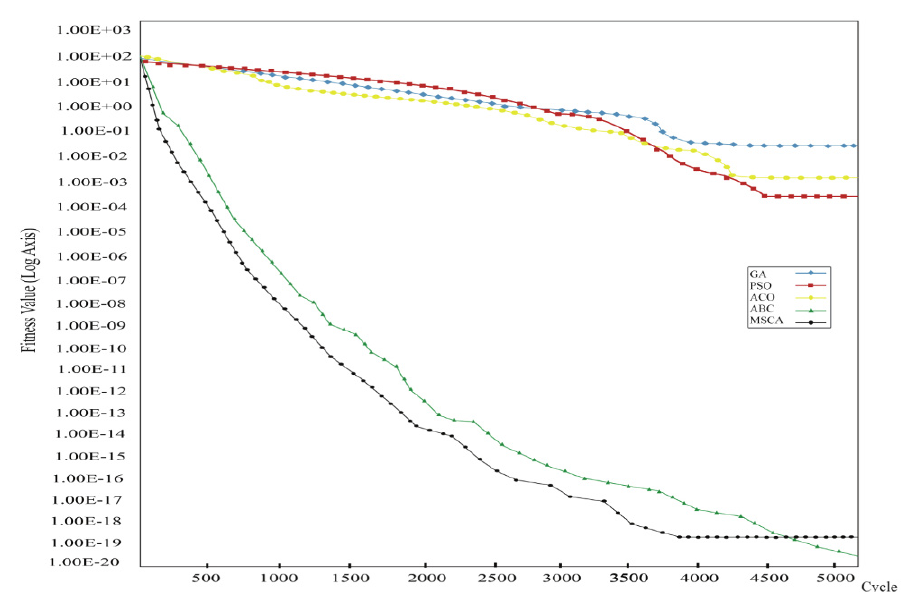
Figure 6. The results of applying different algorithms on Weierstrass function.